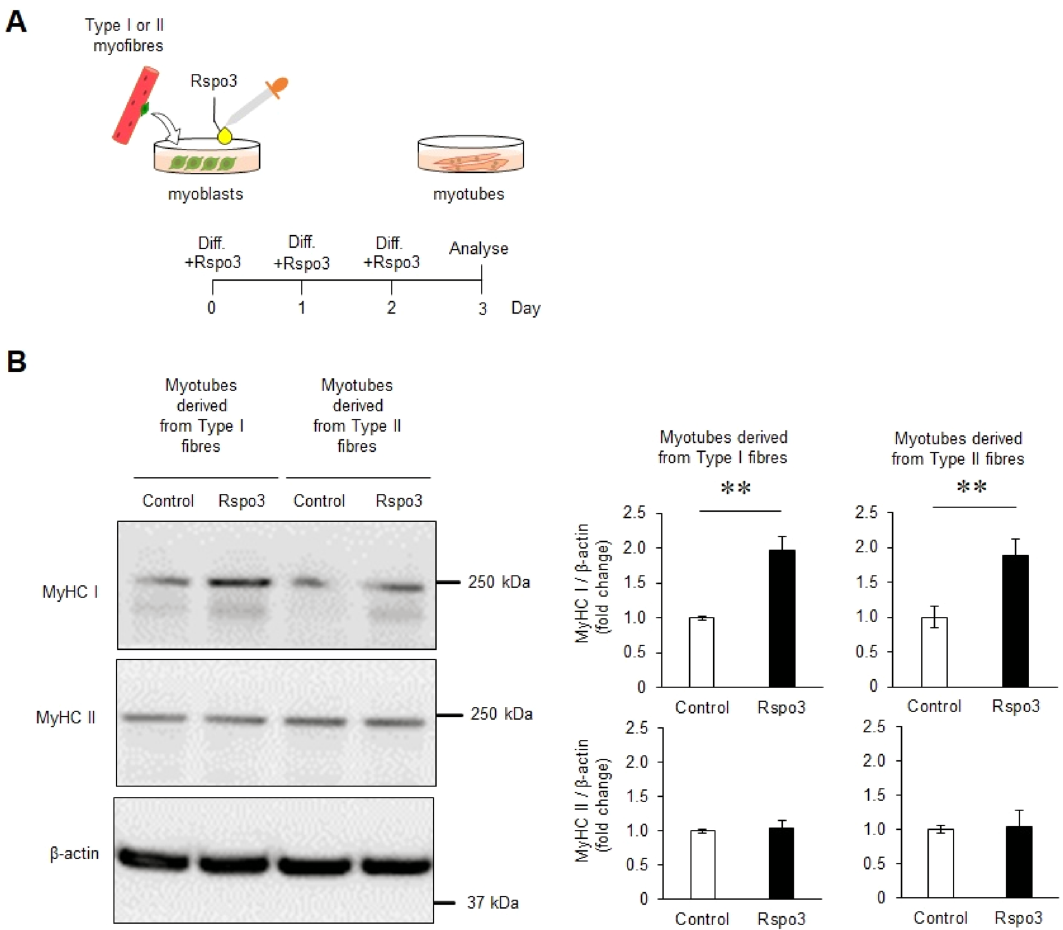
Figure 2. Rspo3 treatment increases MyHC I expression in myotubes. ( A ) Experimental scheme. Mouse primary myoblasts derived from satellite cells of type I or type II fibres were cultured for 3 d in a differentiation media containing BSA (200 ng/mL; Control) or mouse Rspo3 recombinant protein (200 ng/mL; 6.45 nM). ( B ) Protein levels of MyHC I and MyHC II in the differentiated myotubes were measured by Western blotting. The expression of these proteins was normalised to that of β-actin. Values are presented as mean ± SEM (n = 6 mice for analysing MyHC I, n = 4–5 mice for analysing MyHC II). ** P < 0.01 by Student’s t-test. Uncropped blots can be found in Supplementary Fig.